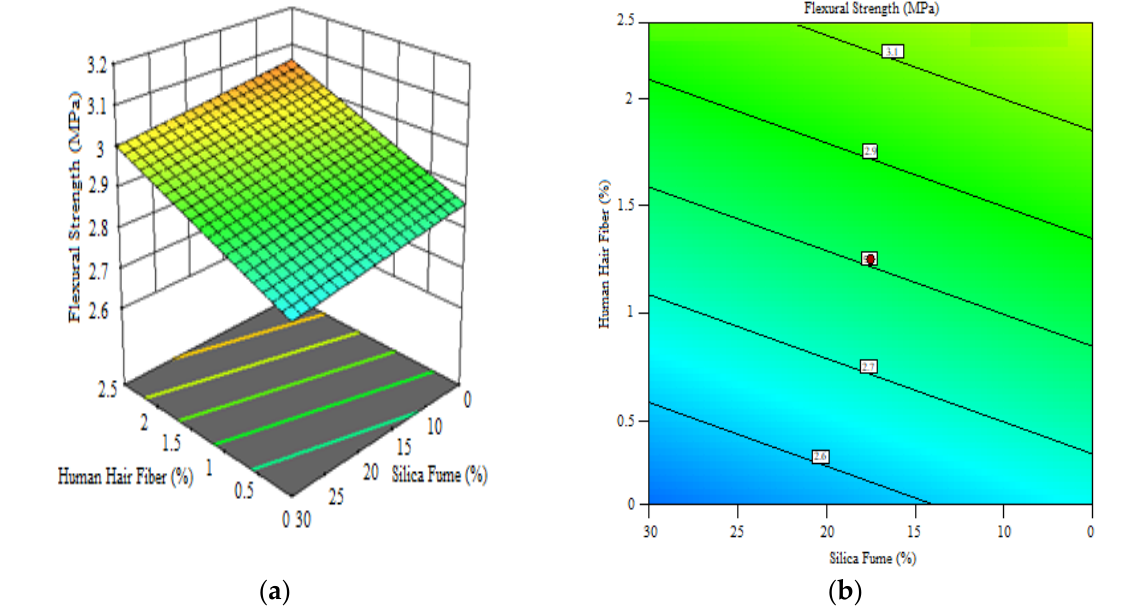
Figure 6. ( a ) 3D surface diagram for flexural strength; ( b ) 2D contour for flexural strength.